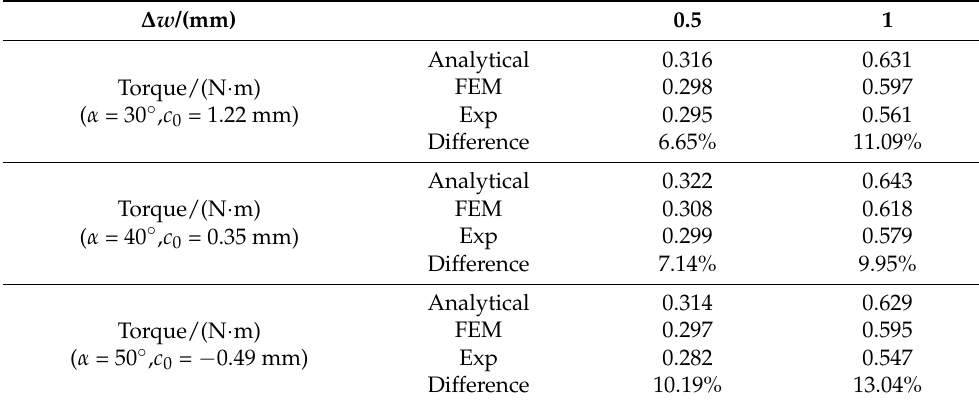
Table 5. Summary of output torque